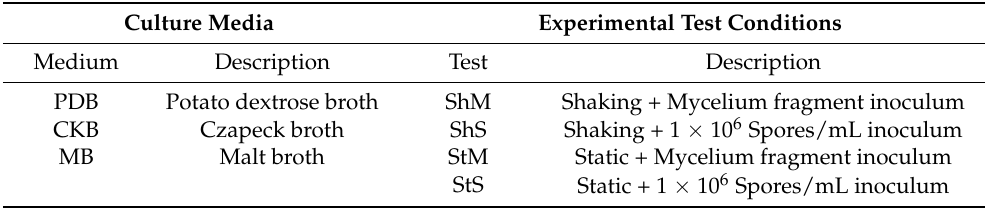
Table 1. Culture media and experimental test conditions used to evaluate the level of production of